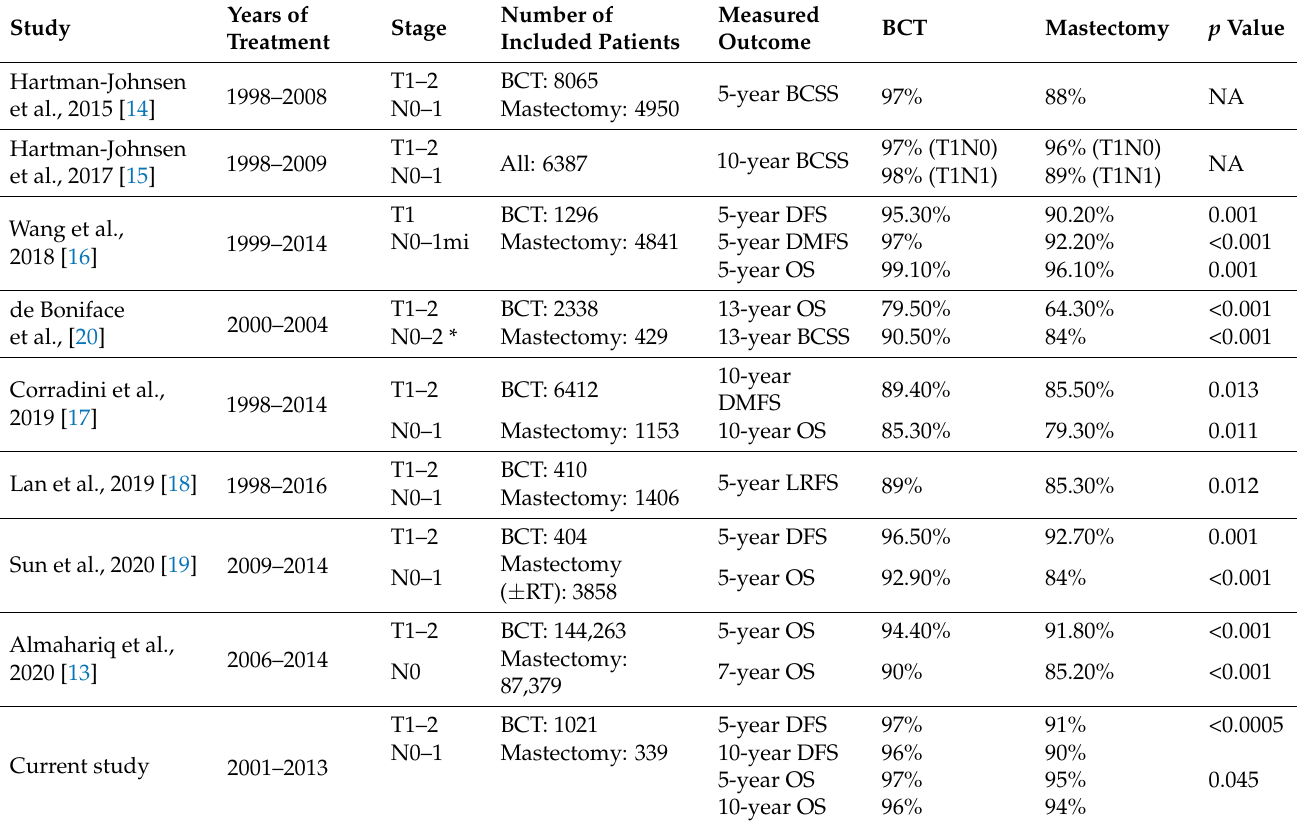
Table 6. Published studies comparing breast-conserving therapy with mastectomy for patients with stage I-II breast